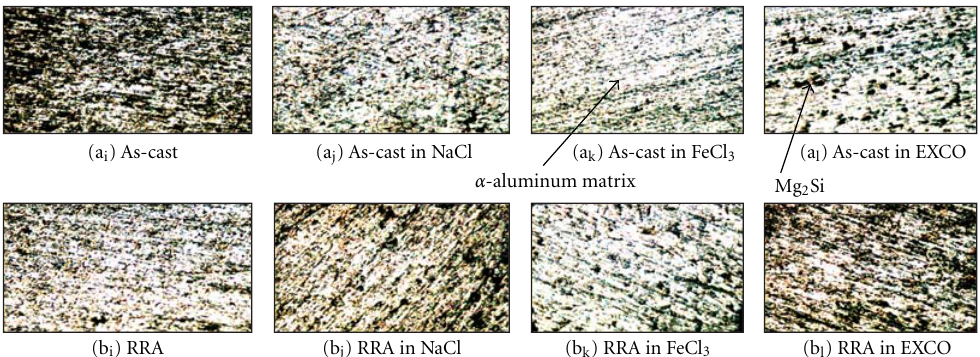
Figure 9: Micrographs of 1.51% Mg addition for untreated (a i –a l ) and treated (b i –b l ) specimens.